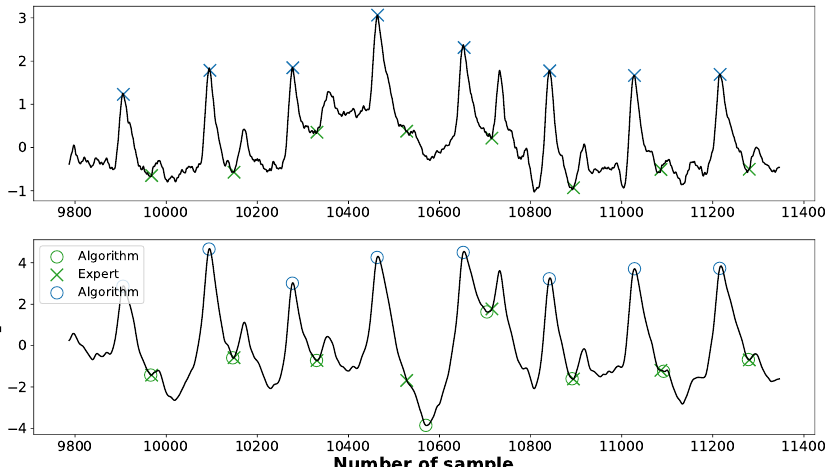
Figure A2. An example of X point misidentification due to the hardly noticeable local minimum in the original